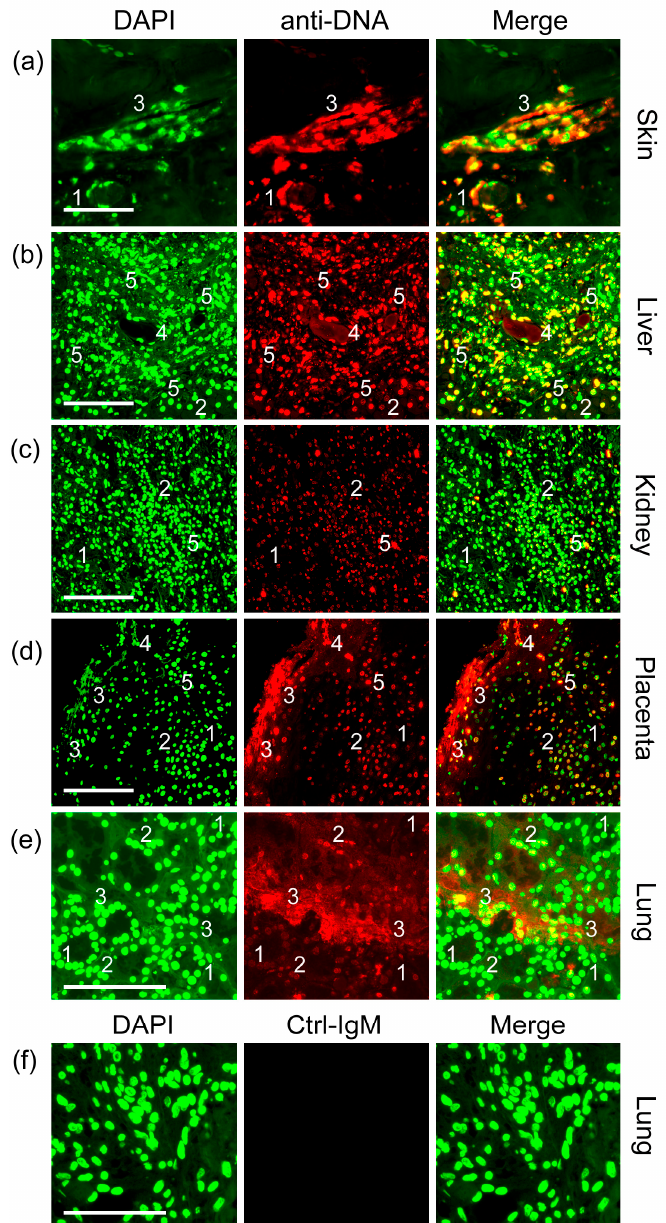
Figure 1. Anti-DNA-IgM antibody surpasses DAPI in staining decondensed DNA. We analyzed paraffin sections from specimens of ( a ) skin (n = 7), ( b ) liver (n = 7), ( c ) kidney (n = 7), ( d ) placenta (n = 8), and ( e ) lung (n = 7) of patients with COVID-19. DAPI (green), anti-DNA-IgM (red), and merged images are shown in the left, middle, and right panels, respectively. ( f ) Isotype control. Note, condensed nuclei show a strong DAPI signal and (1) no or (2) faint anti-DNA-IgM staining. (3) The spread extracellular DNA (ecDNA) of neutrophil extracellular traps (NETs) is preferentially stained using the anti-DNA-IgM antibody and (4) some vessels display intravascular DNA which is below the threshold of detection using DAPI. (5) Nuclear remnants in cellular debris are equally stained by DAPI and anti-DNA-IgM. Scale bar = 100 µ